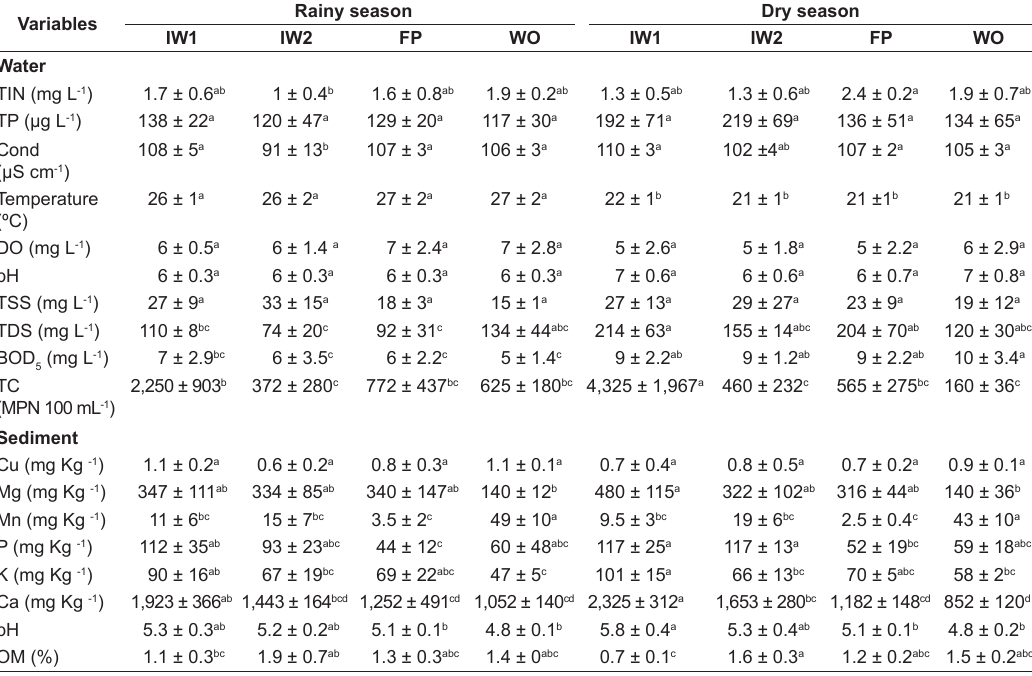
Table 1. Mean and standard deviation of variables measured in the water and sediment during the rainy and dry seasons (IW1 and IW2 = water inlets; FP = deep water site; WO = water